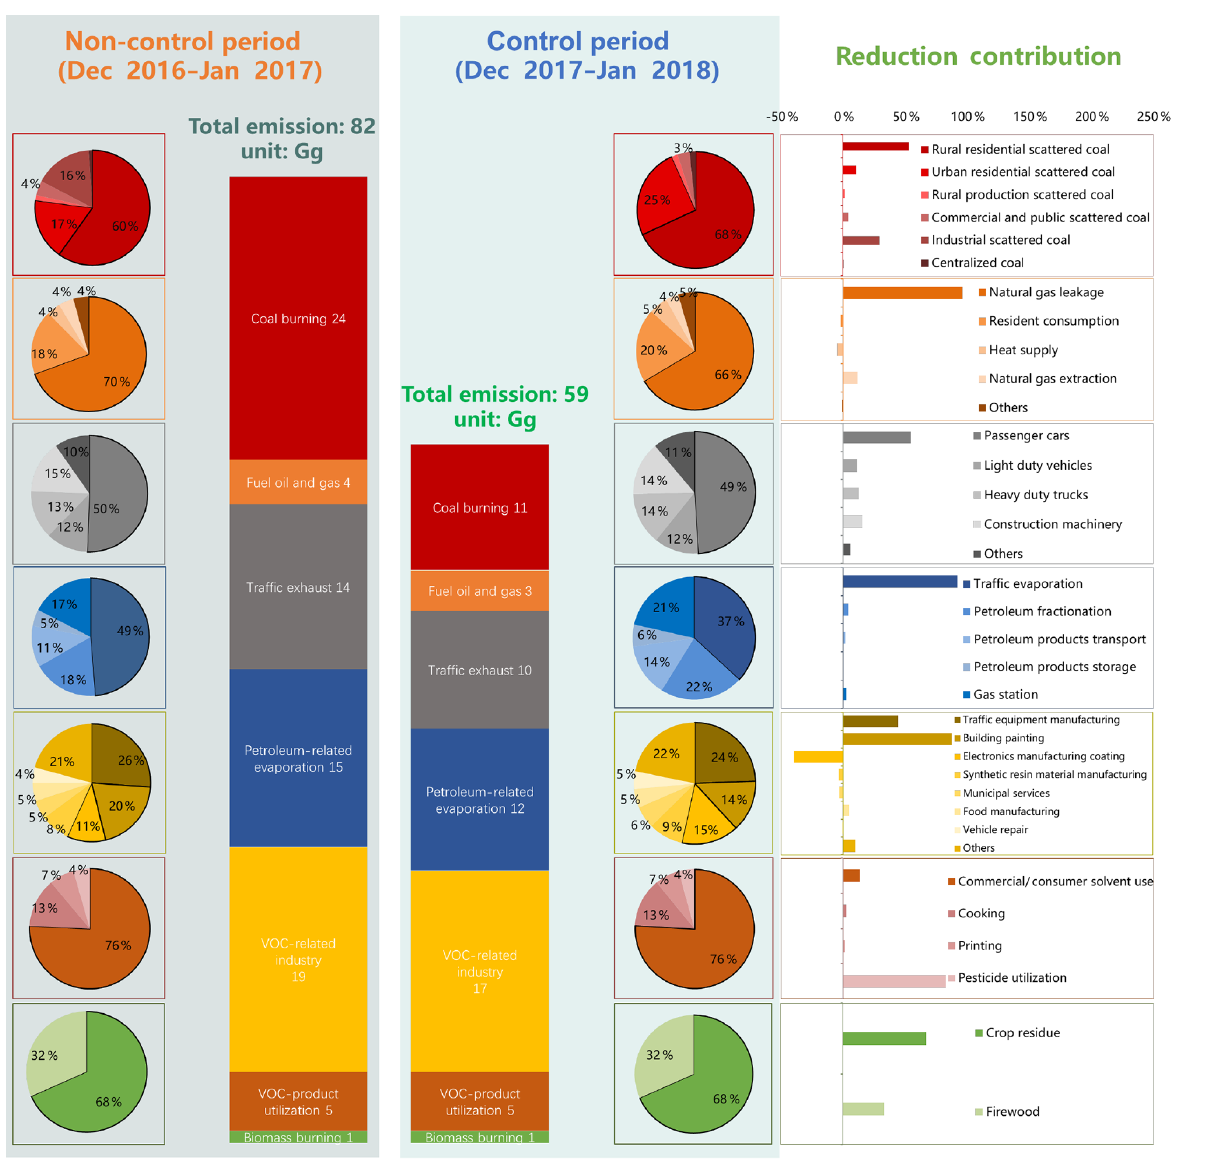
Figure 7. Emissions (Gg) of seven sublevel anthropogenic sources of Level 1, major refined sub-contributors of each anthropogenic source, and reduction contribution of each refined sub-contributor from non-control to control